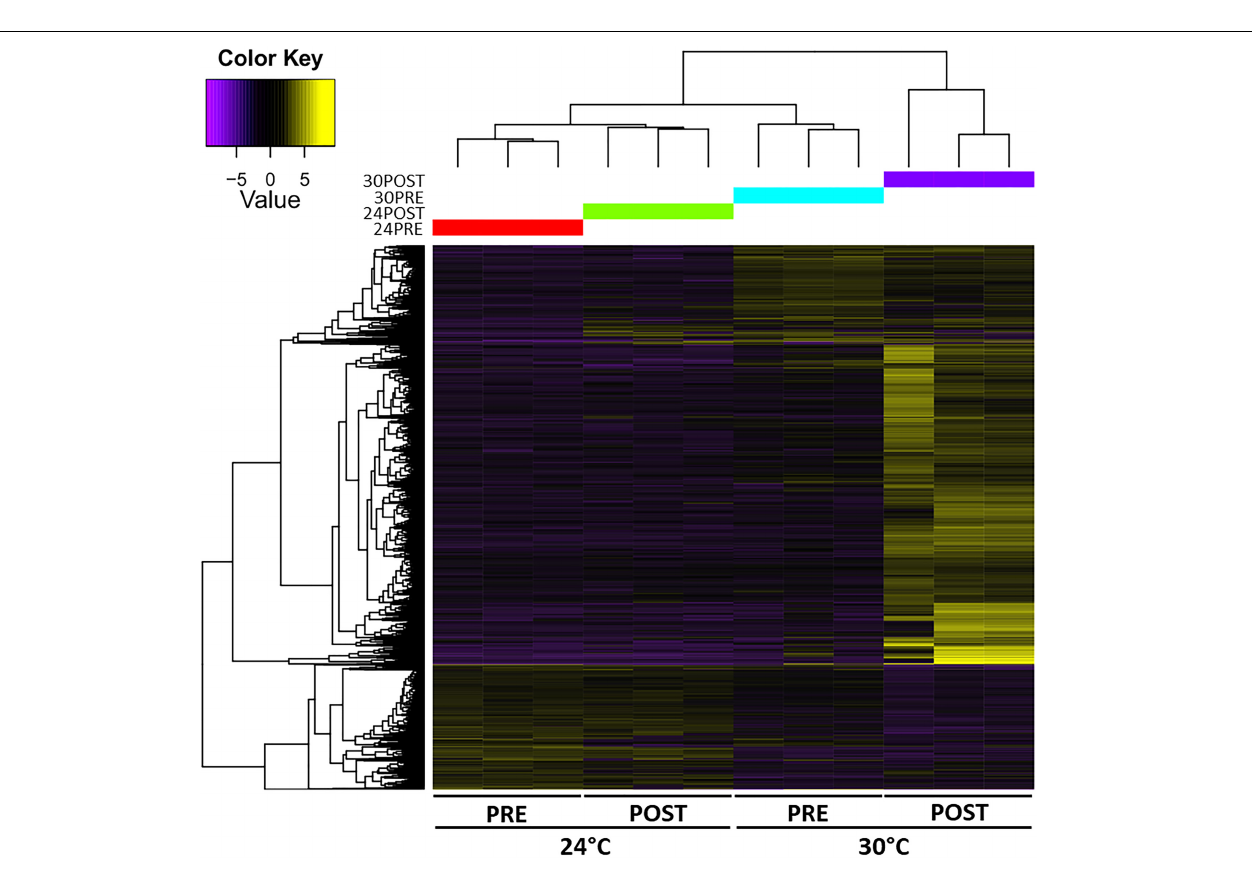
FIGURE 4 | Heatmap of the abundance of differentially expressed transcripts (rows, FDR < 0.05, Fold change > 2) in the O. maya testis transcriptome in each treatment (columns). The dendrogram shows that temperature modulated the expression patterns. Treatments: 24PRE – control treatment exposed to 24 ◦ C; 24POST – mated and exposed to 24 ◦ C; 30PRE – exposed to 30 ◦ C; 30POST – mated and exposed to 30 ◦ C.